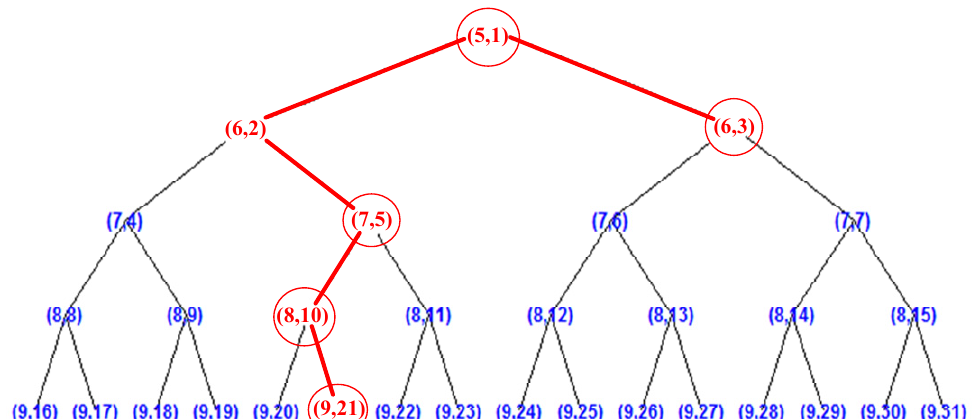
Figure 6. WPSA ‐ based algorithm. Figure 6. WPSA-based